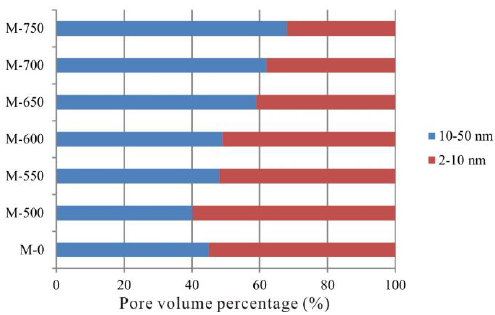
Figure 7. Percentage of mesopore PV for shale samples at different temperatures.